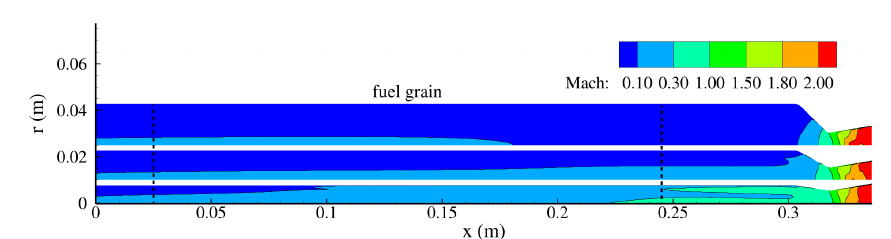
Figure 5. Effect of port diameter on regression rate and pressure for test 4 of set 1.